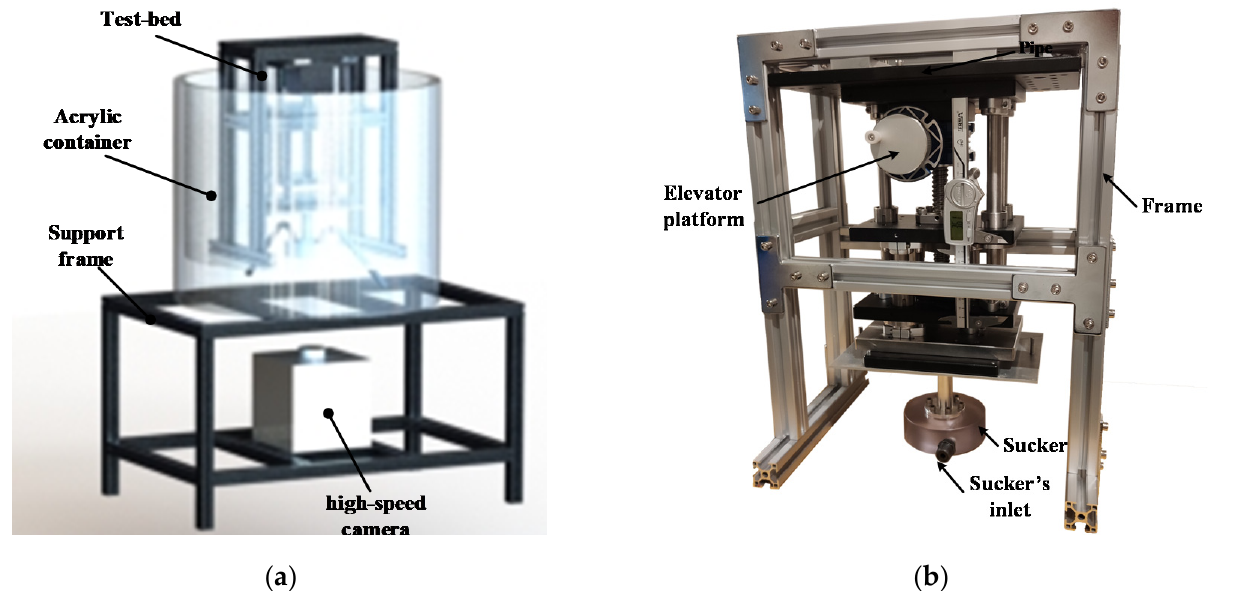
Figure 5. Vortex observation experimental setup: ( a ) schematic diagram of vortex observation experimental platform; ( b ) physical photograph of vortex observation apparatus.